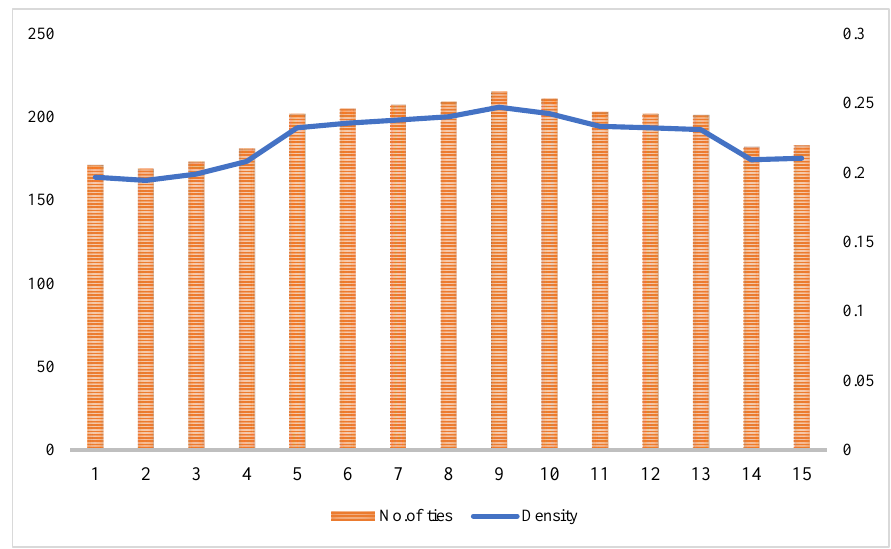
Figure 5. Linkage intensity of the IGGE spatial correlation network, 2006–2020.